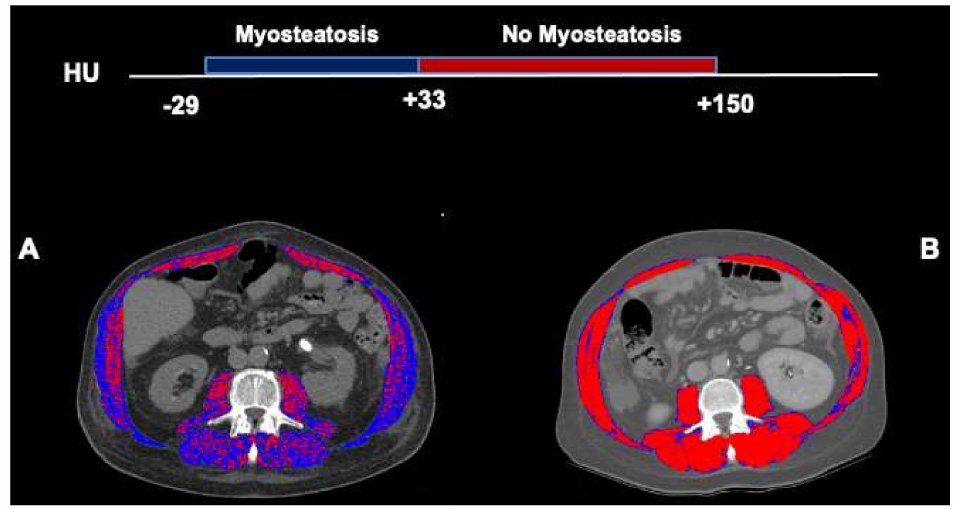
Figure 1. Abdominal computed tomography images taken at the 3rd. lumbar vertebra to quantify muscle radiodensity in patients with cirrhosis. Comparison of two male patients with cirrhosis